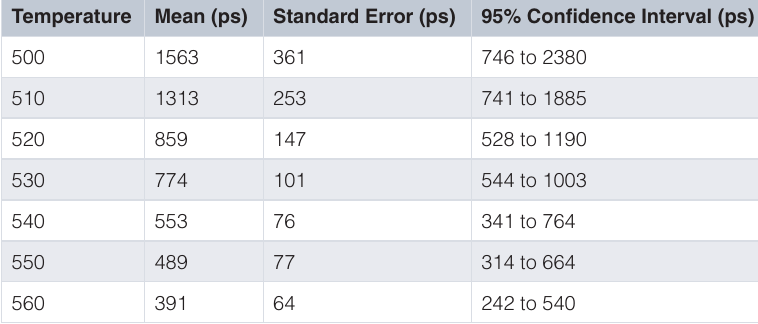
Table 3. Time for the RMSD to go above 0.4nm from the initial crystal structure in